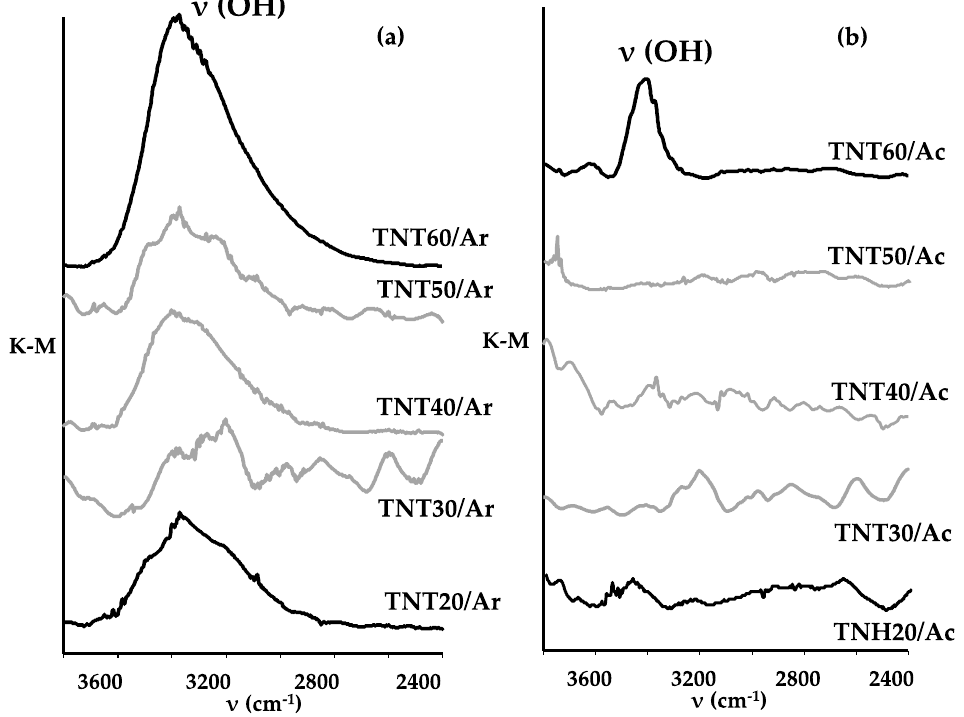
Figure 5. IR DRIFT spectra of ( a ) Ti6Al4V/TNT20-60/Ar and ( b ) Ti6Al4V/TNT20-60/Ac systems.